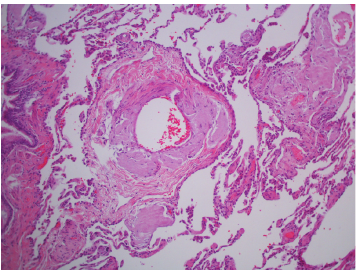
Figure2:Thickenedintrapulmonaryvesselwithadjacentinterstitial eosinophilic amorphous material confirmed to be amyloid on Congo Red. (H&E, 100x).